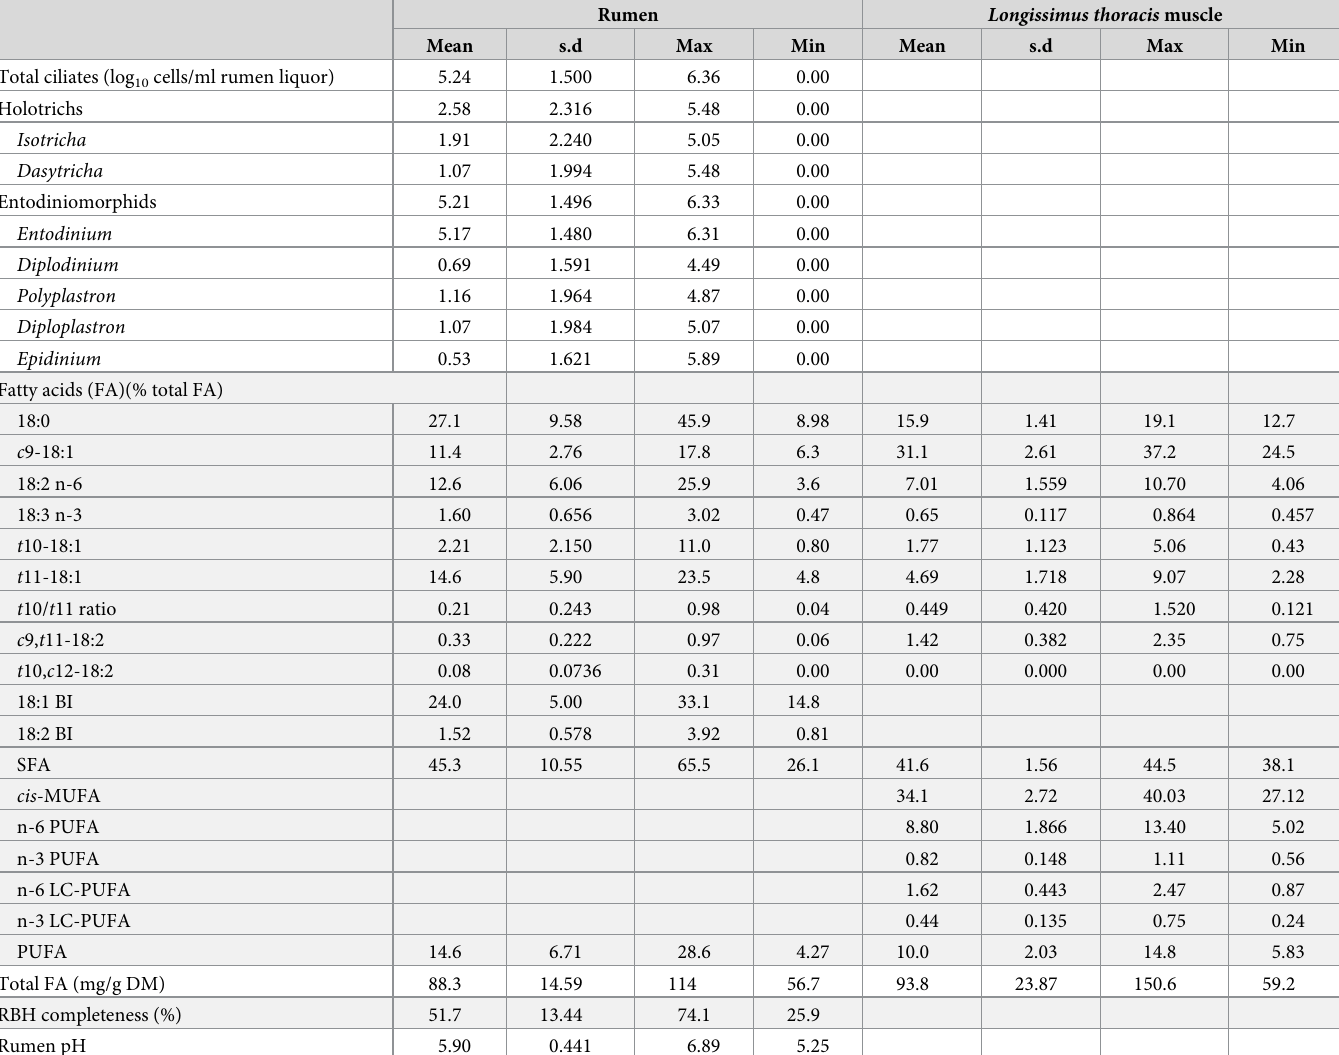
Table 3. Mean, standard deviation, minimum and maximum values for the phenotypes identified in Experiment